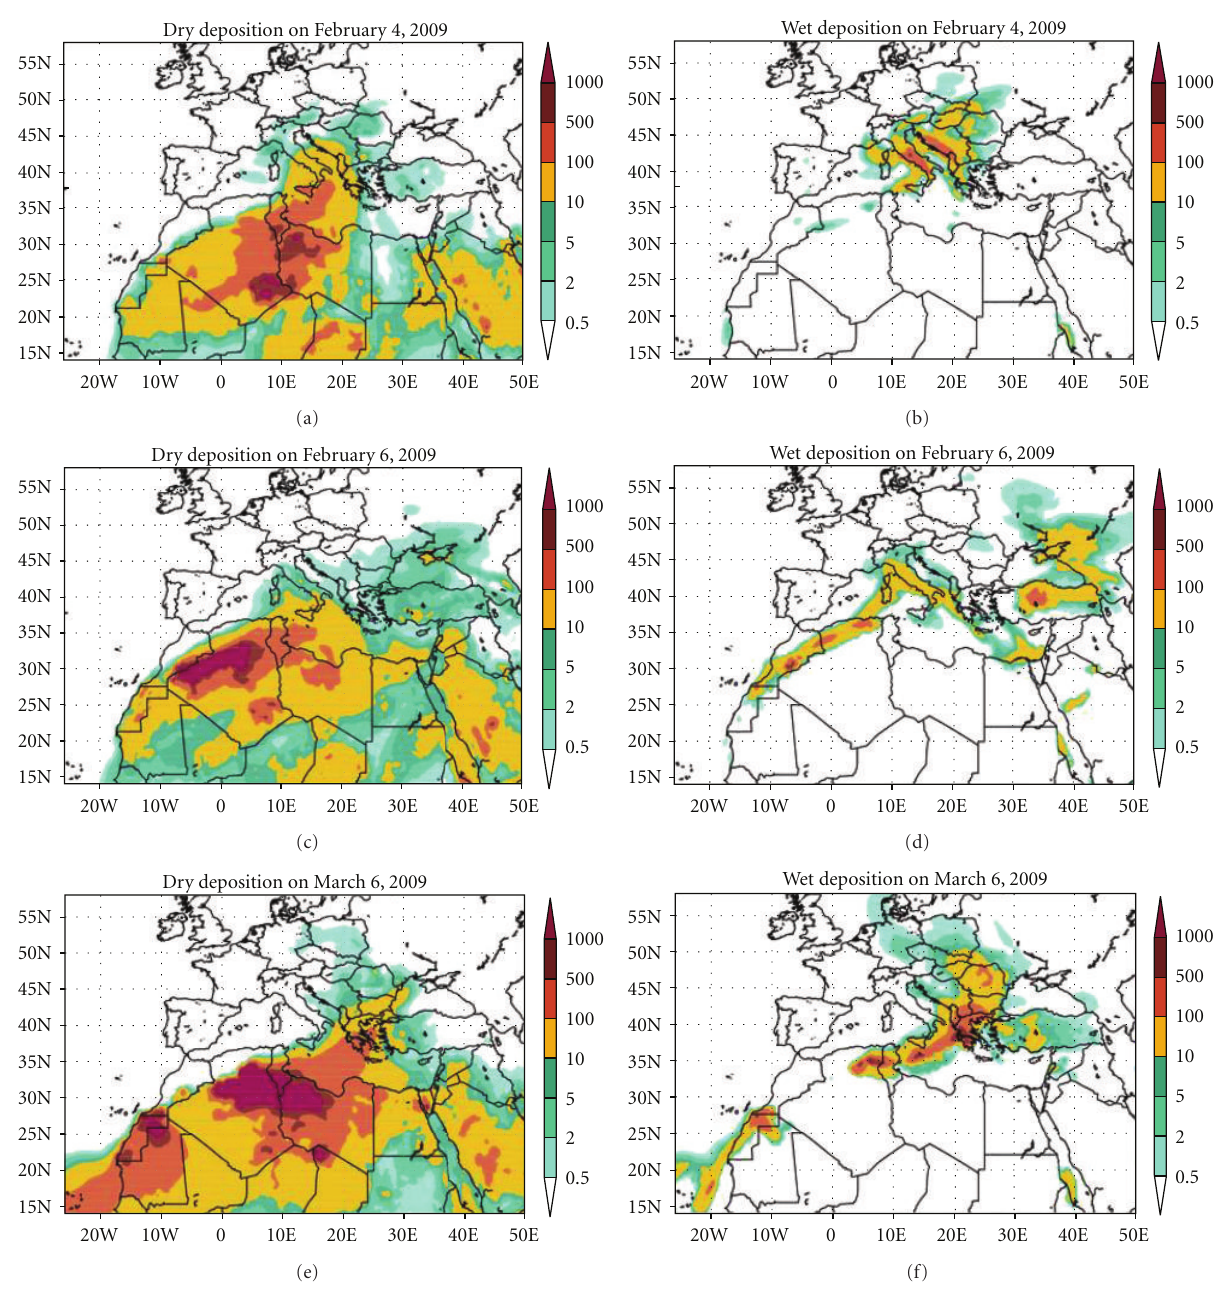
Figure 4: DREAM 24 h forecast for 12:00 UTC for dry ((a), (c), and (e)) and wet ((b), (d), and (f)) dust depositions (mg/m 2 ) on February 4, 2009 ((a) and (b)), February 6, 2009 ((c) and (d)), and March 6, 2009 ((e) and (f)).